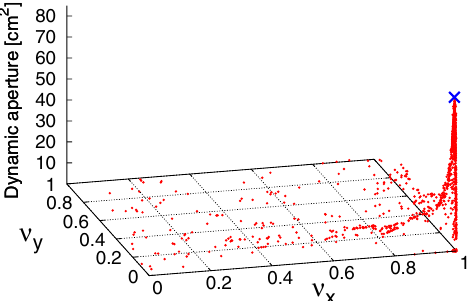
FIG. 10. Dynamic aperture versus the fractional betatron tunes for the simulation in Fig. 9.